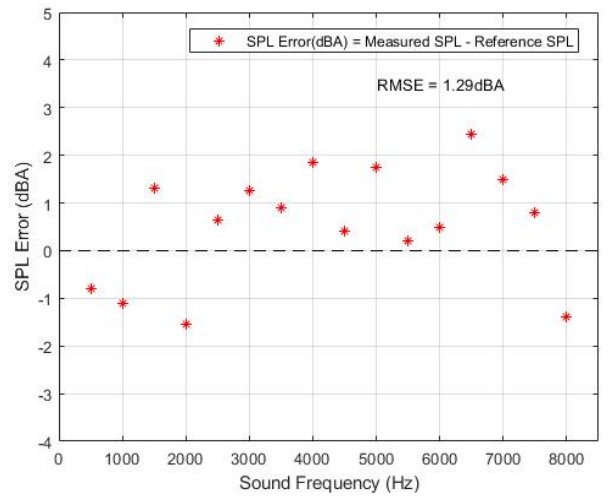
ff erent frequency